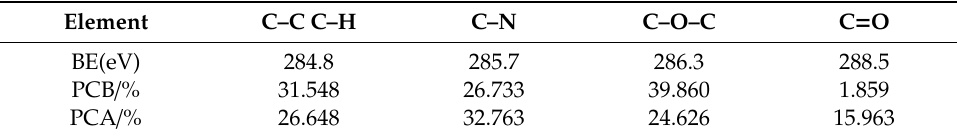
Figure 13. Component-fitted XPS spectra of the C1s peaks of polyurea coating ( a ) before and ( b ) after aging. Table 3. Component-Fitted C1s Spectra of polyurea before and after